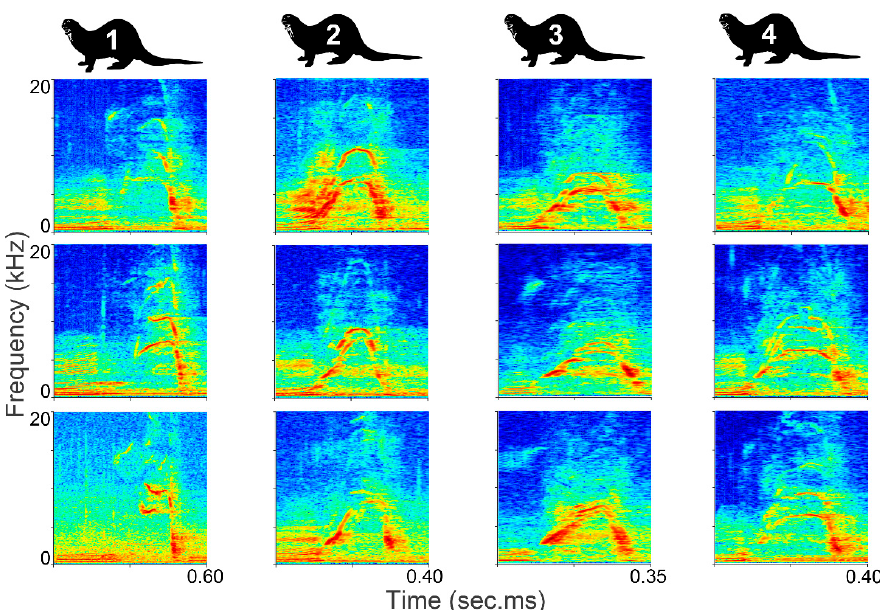
Figure 3. Cohesion calls of the giant otters. Three of the selected cohesion calls per individual are shown.